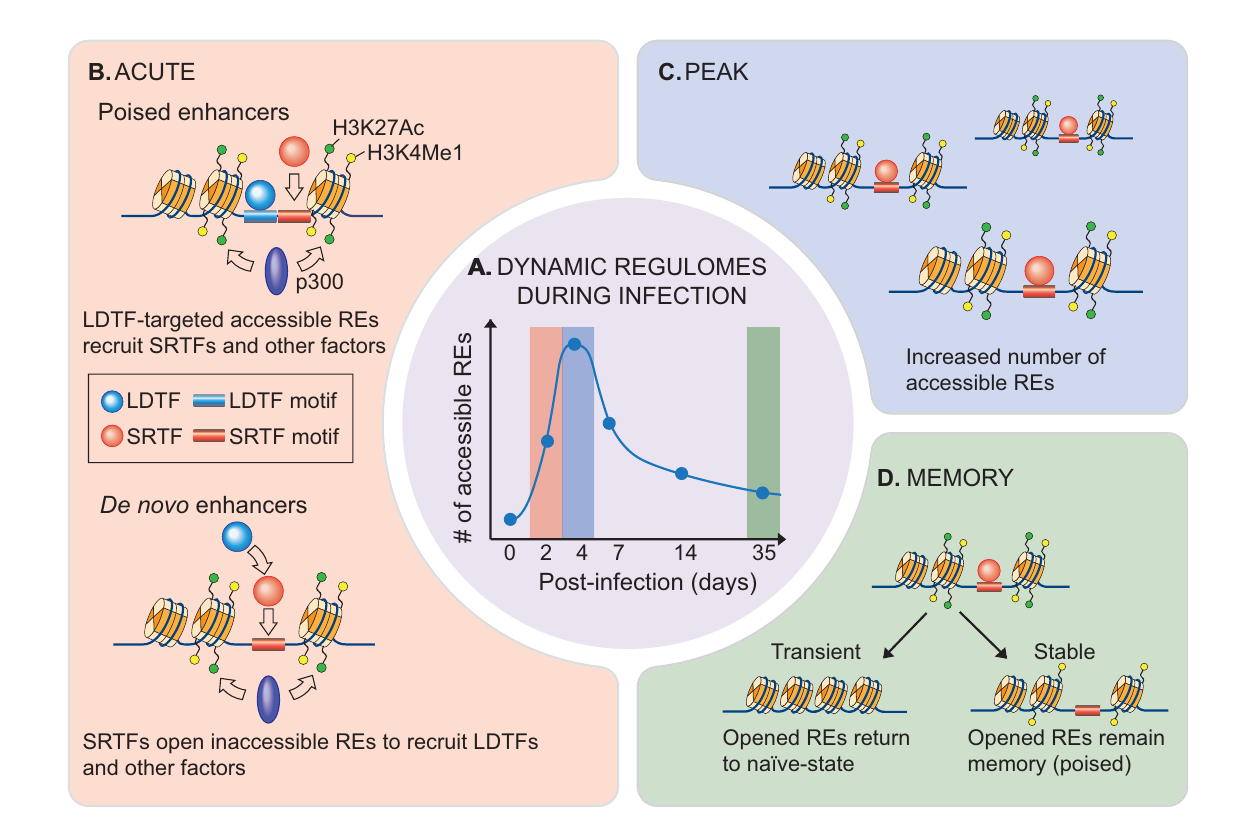
FIGURE 1 | Dynamics of NK cell regulomes during infection. (A) Dynamic regulomes during infection. Innate immune response occurs along with changes in gene expression as well as chromatin accessibility. (B) High-magnitude gene upregulation during NK cell activation relies on recruitment of signal-regulated transcription factors (SRTFs) to poised enhancers that are developmentally acquired in a lineage-determining transcription factors (LDTFs) manner for chromatin remodeling (top) (72). High-magnitude gene induction also forms de novo enhancers through a process involving sequence-speci fi c binding of SRTFs to inaccessible chromatin regions, followed by LDTF recruitment and enhancer activation (bottom) (72). (C) Formation of new accessible sites rapidly occurs in vivo upon mouse cytomegalovirus or Toxoplasma gondii infection until a peak of the response is reached (69). (D) At the end of viral infection, majority of these rapidly opened chromatins return to resting state, while part of them undergo stable epigenetic poising that maintains NK cell adaptive-like or memory phenotype (69,